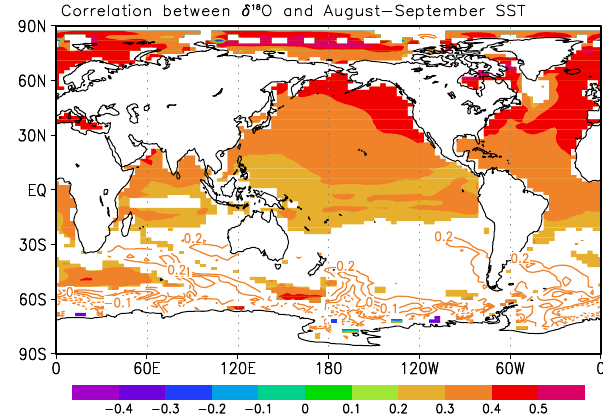
Fig. 11 . Same as in Fig. 10 but for the correlation between the Guliya δ 18 O - Fig. 11. Same as in Fig. 10, but for the correlation between the Guliya δ 18 O-temperature proxy record and the simulated August– temperature proxy record and the simulated August–September SST. September SST.